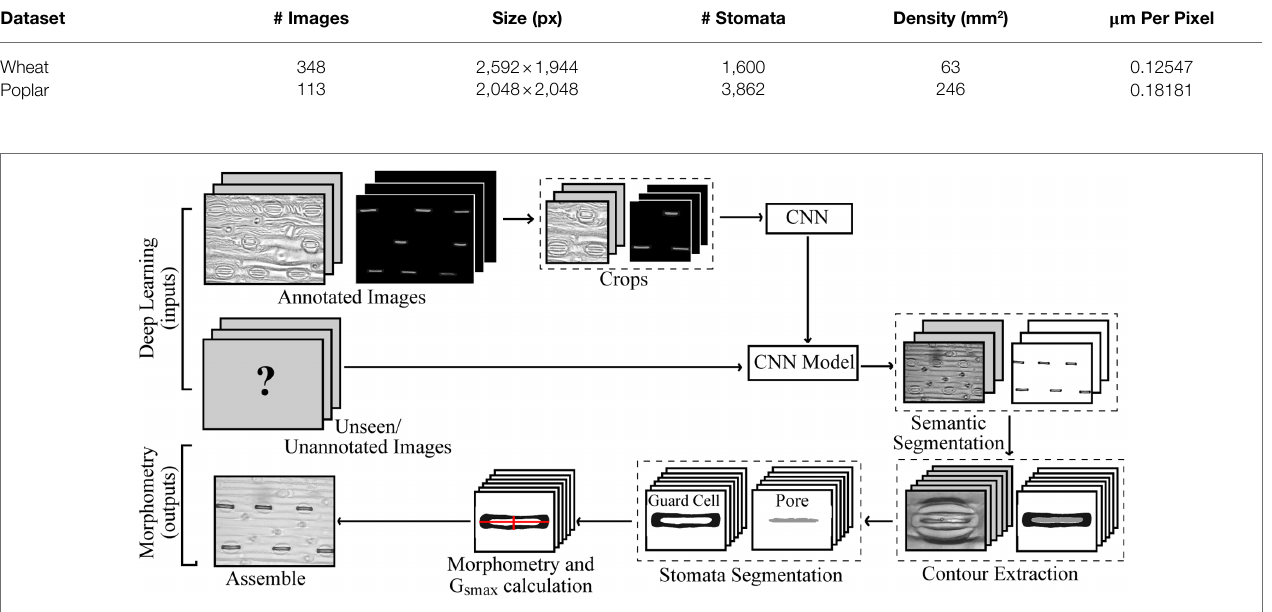
TABLE 1 | Overview of image datasets and properties.